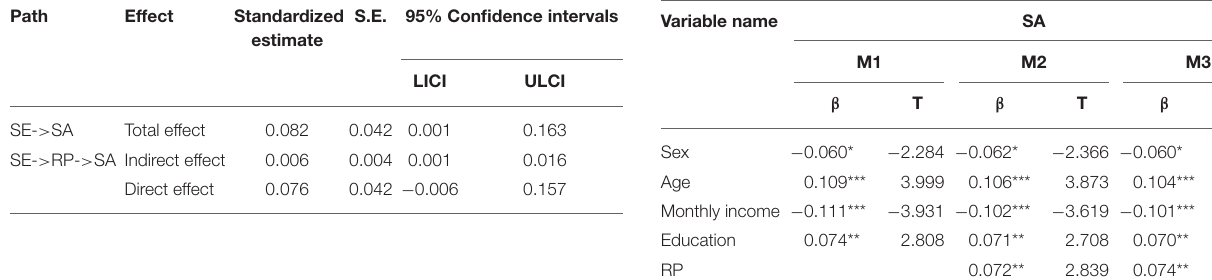
TABLE 5 | Results of mediating effect during pandemic ( N = 1511).